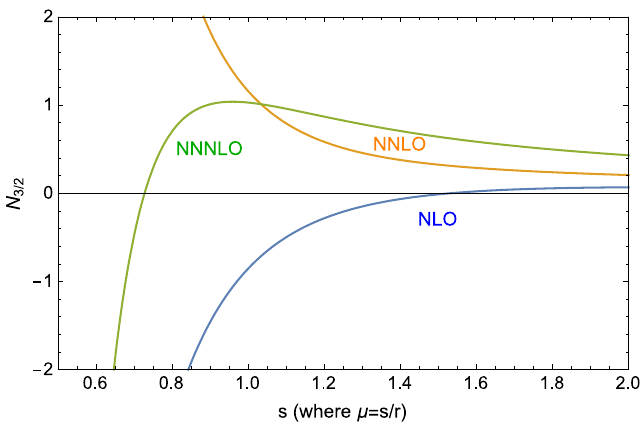
Figure 5 . Scale dependence of the normalization constant N